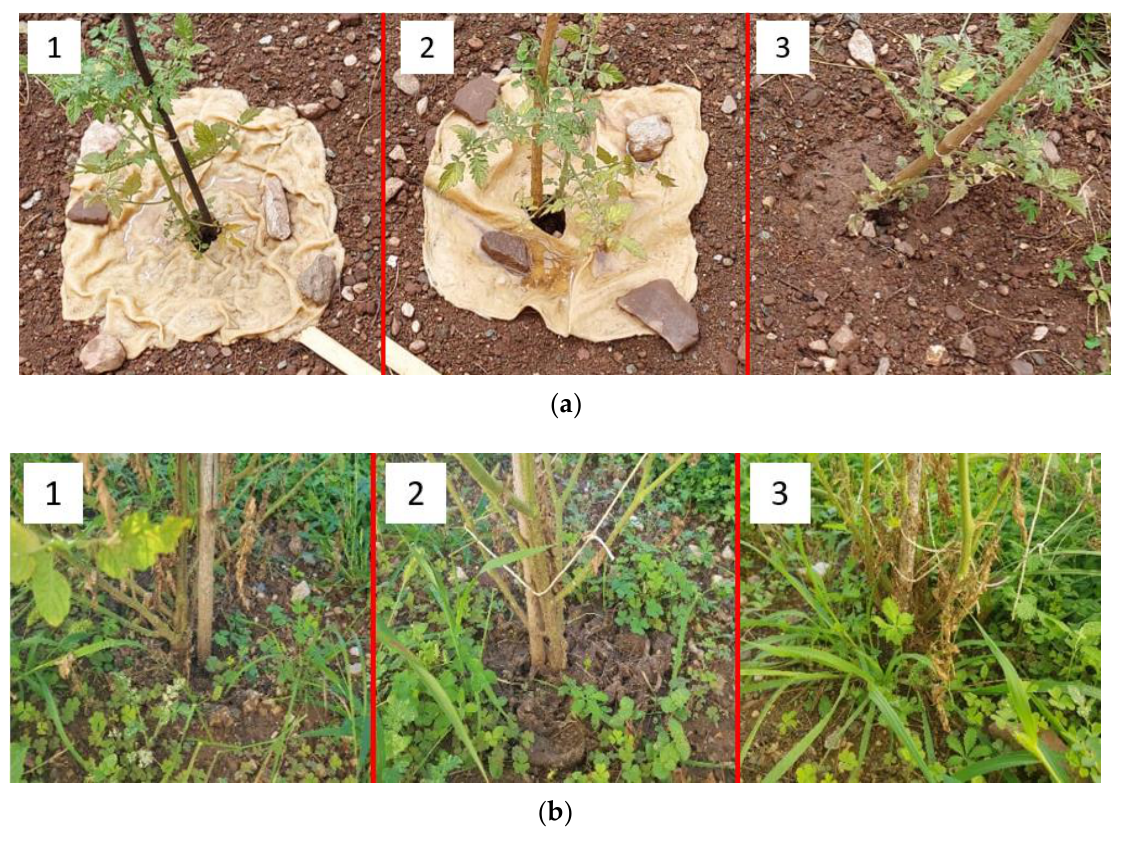
Figure 13. Visual aspect of the TSC ( a ) after 6 days and ( b ) after 80 days. (1) not crosslinked TSC, (2) crosslinked TSC, and (3) without TSC